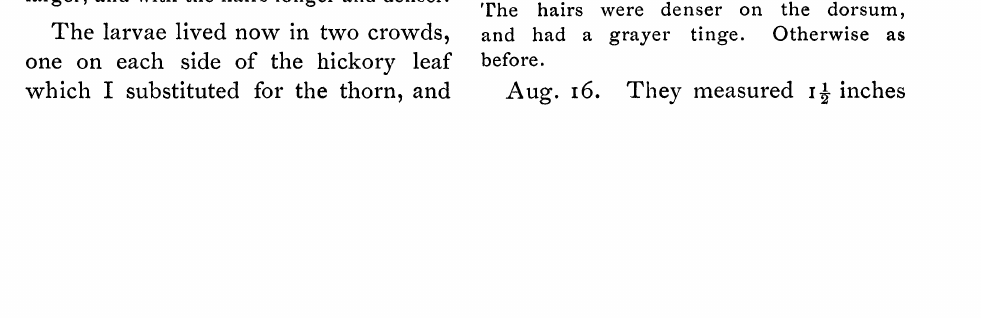
Head, feet, props and renter black. Body more speckled with black, the ground color being greenish white. Short, thick, white pencils on each side of the dorsal black ones, lay close against these, and formed with them a convex ridge along the dorsum. The lateral hairs were less dense and longer. Two thin long, white pencils on st, nd, xxth and 2th segments, the first two pairs extending over the liead, the last two over the anal